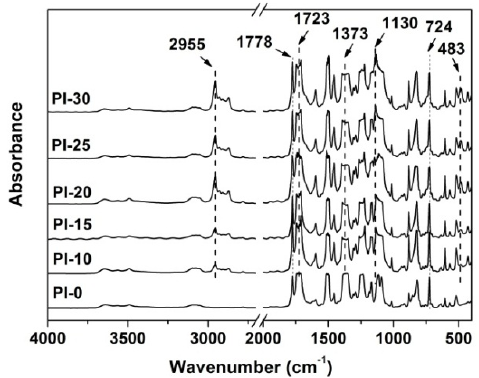
Figure 5. Attenuated total reflectance Fourier transform infrared (ATR-FTIR) spectra of PI coatings.